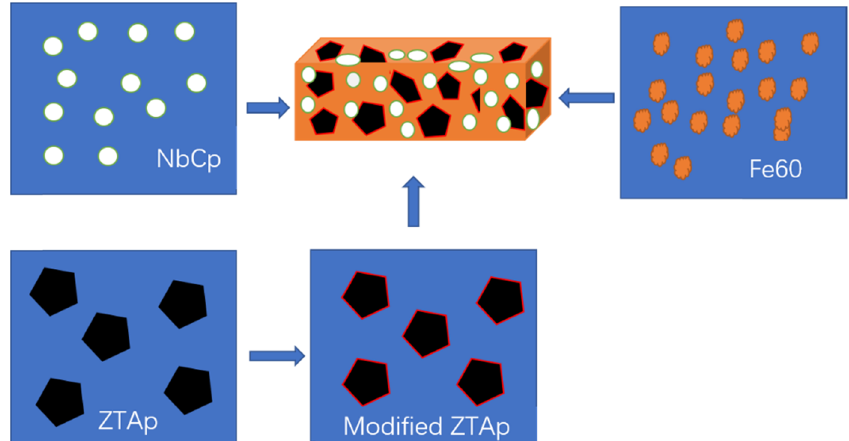
Figure 2: The design steps of composite materials.